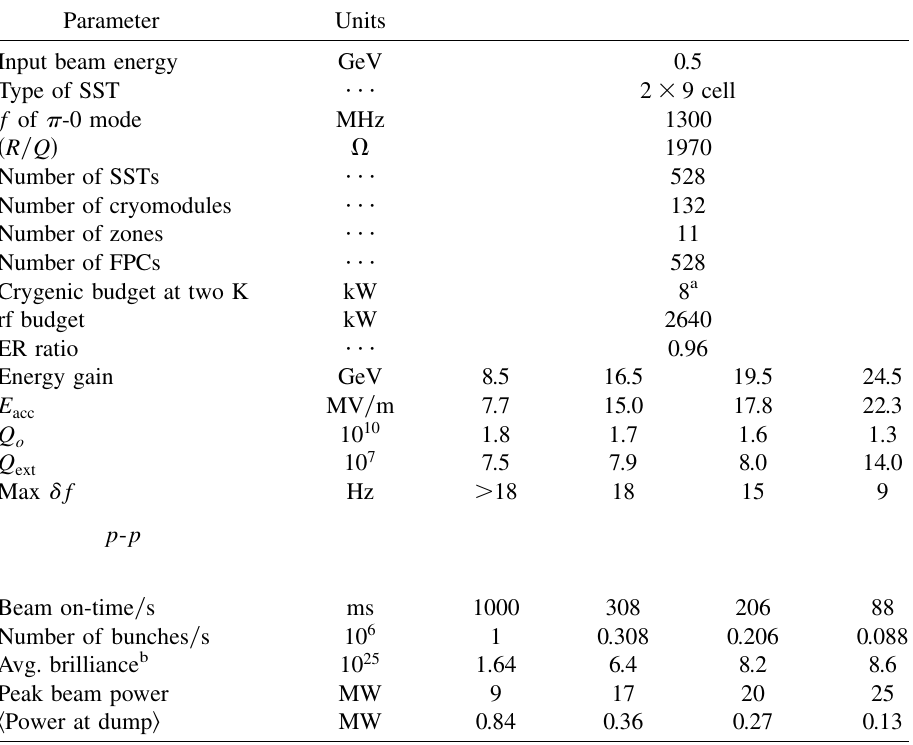
TABLE V. Parameters of the ER part of the linac.